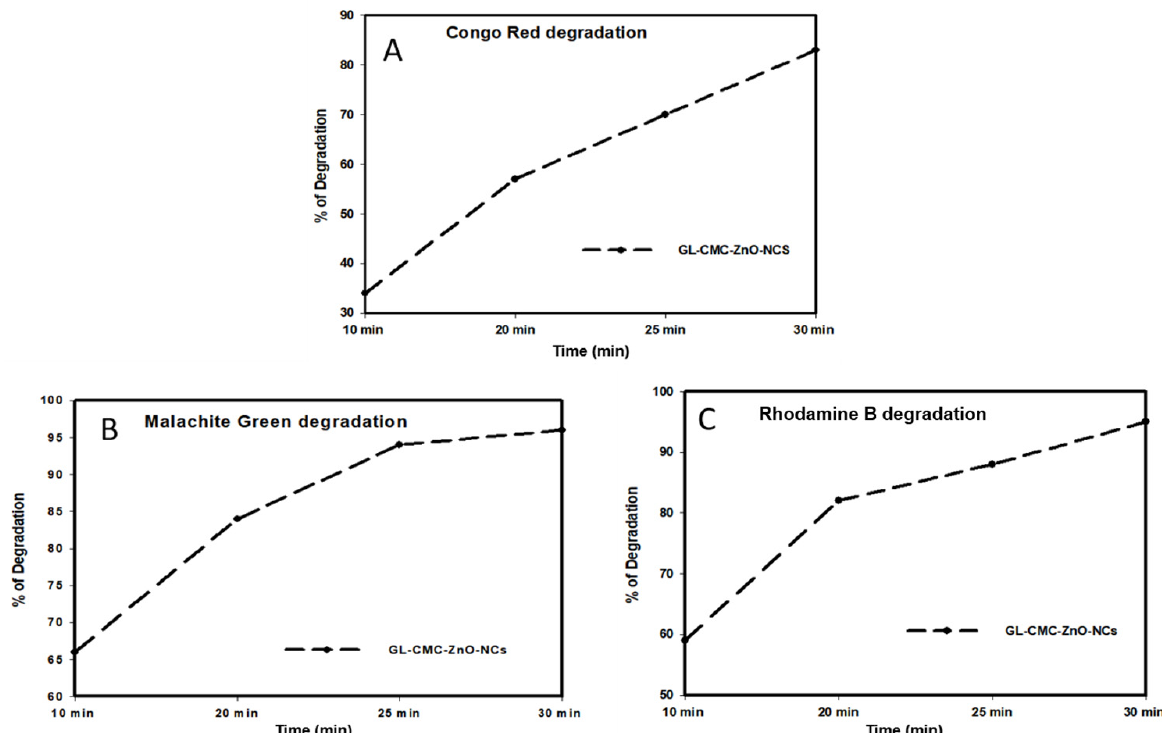
Figure 11. Comparison study for the dye degradation rates using the GL–CMC–ZnO NCs: ( A ) CR degradation rates; ( B ) MB degradation rates; ( C ) RB dye degradation rates.